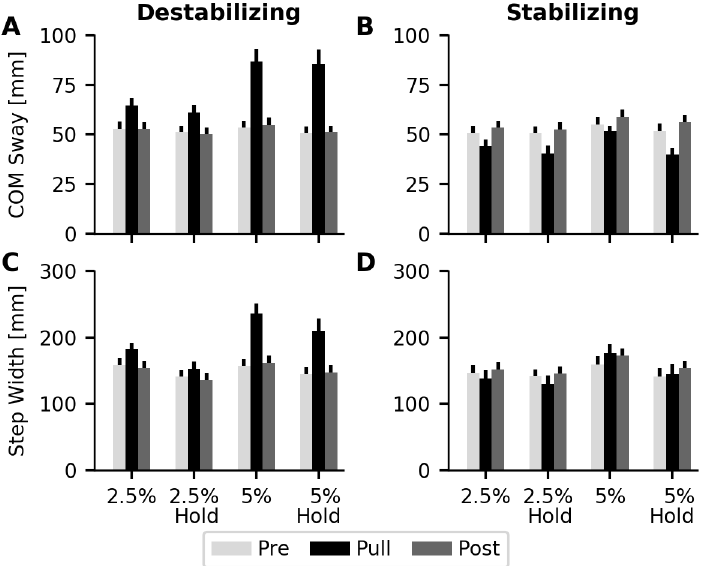
Fig 5. Average COM sway and step width response to perturbations. The destabilizing perturbations increased COM sway (A) and step width (C), with larger changes observed at higher perturbation forces. Conversely, the stabilizing perturbations reduced COM sway (B), with smaller reductions observed in step width (D). Handrail hold had a general effect of reducing step width across the entire trial, but a significant effect was only observed for the stabilizing